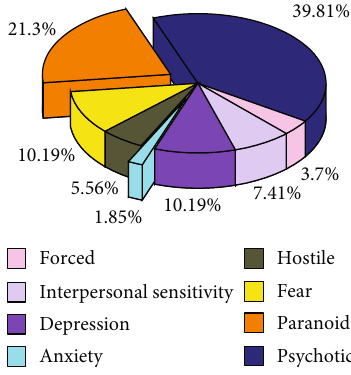
Figure 3: The weights of each factor of SCL-90 in the coping style of the control